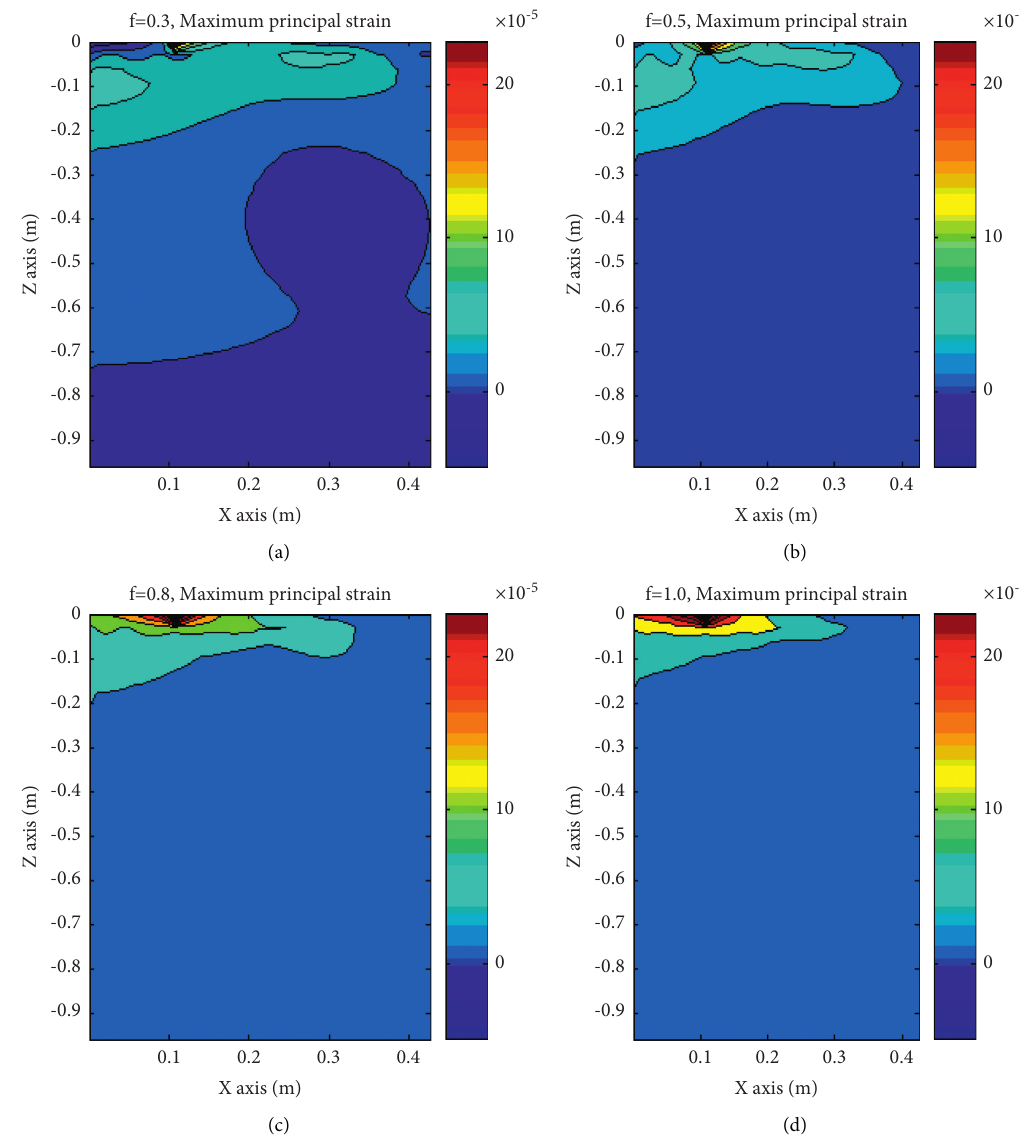
Figure 7: Maximum principal strain nephogram under different friction coefficients. (a) f � 0.3. (b) f � 0.5. (c) f � 0.8. (d) f �